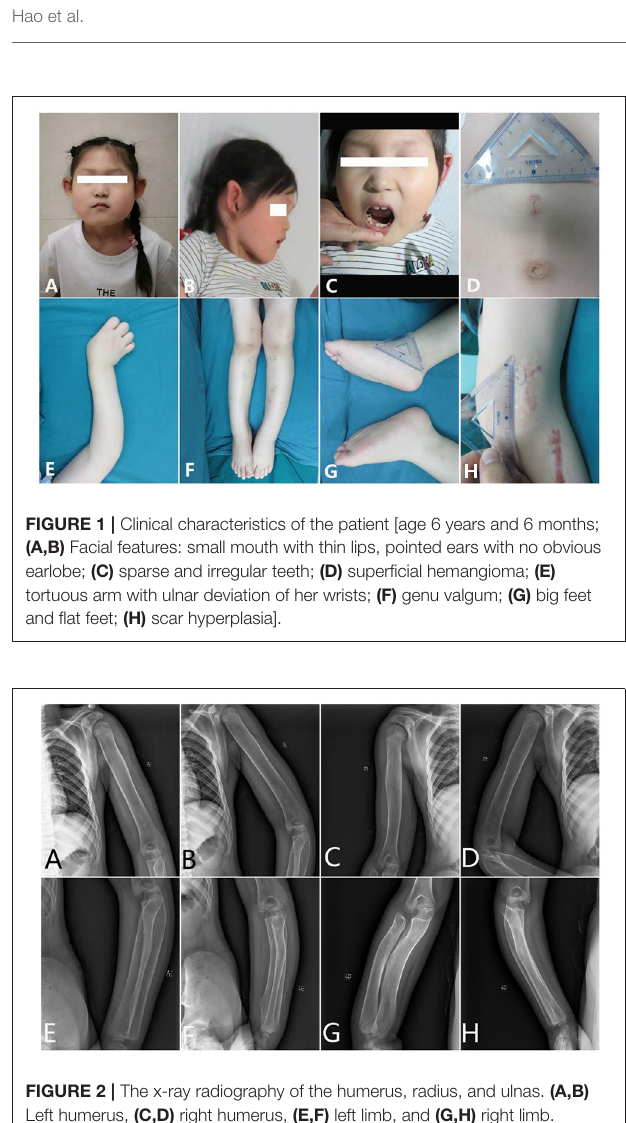
FIGURE 2 | The x-ray radiography of the humerus, radius, and ulnas. (A,B) Left humerus, (C,D) right humerus, (E,F) left limb, and (G,H) right limb. problems. The diaphysis of the long bones was wide and with thin cortexes, but the epiphysis is not as wide as the diaphysis, for example, neither femoral epiphysis is wide, and the growth plates were also very thin compared with her age. The second ossification center of the radial head did not appear. Upper Limb Humerus. The metaphysis was not dilated. The diaphysis was wide and cylindrical and looks like a round rod shape. There was some thickened diaphyseal cortex, but was less than normal. normal shape ( Figure 2 ).